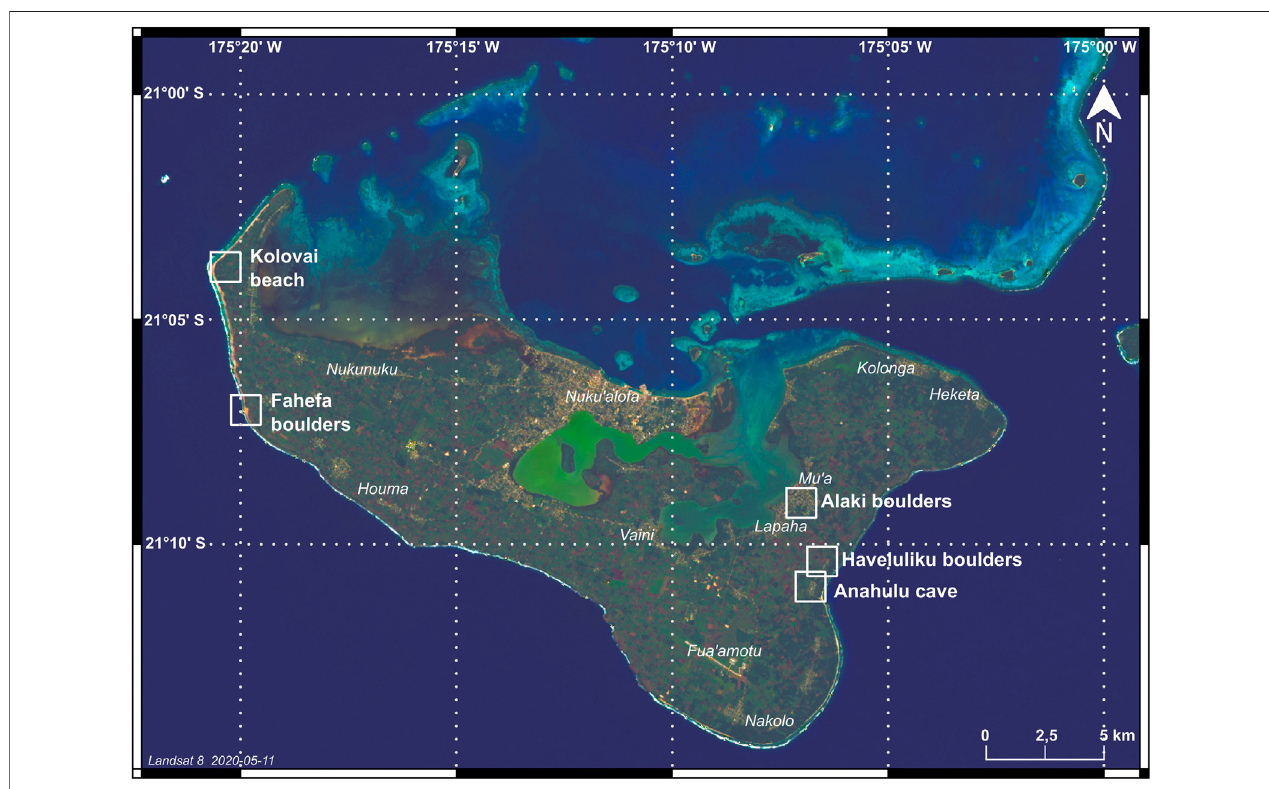
FIGURE 2 | Map of Tongatapu showing study